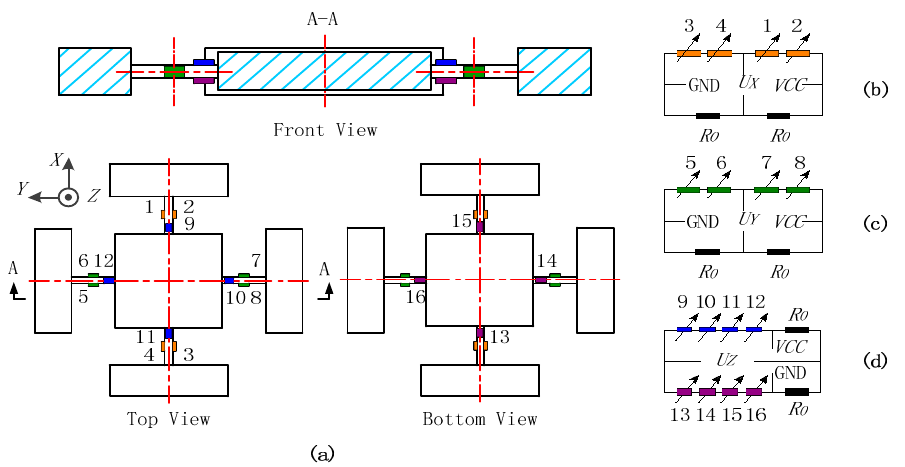
Figure 2. ( a ) Beam deformation under F OY ; ( b ) beam deformation under F OZ ; ( c ) beam deformation under M XY or M YX ; ( d ) beam deformation under M YZ or M ZY ; ( e ) local coordinate system for each elastic beam.